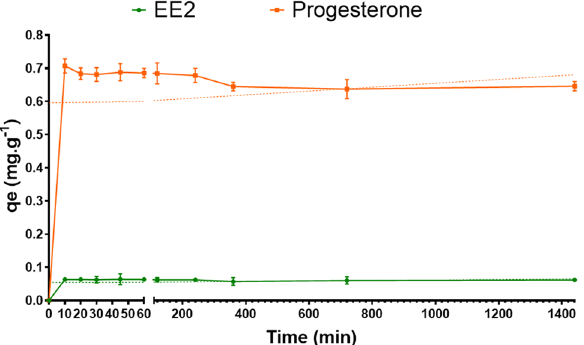
Figure 3. Kinetic adsorption of the biochar for 17α-ethinylestradiol (EE2) and progesterone.